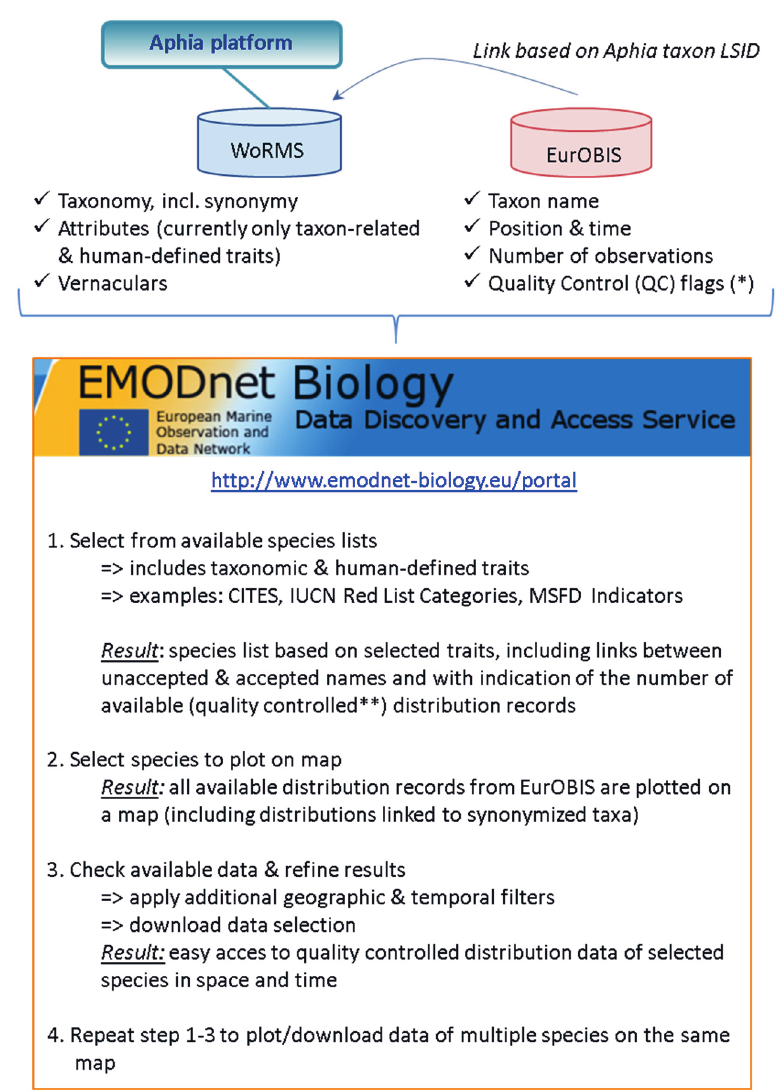
Figure 4. Schematic representation of how WoRMS and EurOBIS are brought together into the EMODnet Biology Data Portal, allowing a combination of taxonomy, traits and distribution information. EMODnet Biology can be seen as a “layer” on top of the EurOBIS database, and is pulling additional taxonomic and attribute data—based on the Aphia taxon LSID—from WoRMS, which is hosted in the Aphia platform. This unique combination allows searching for distribution data based on traits, benefiting from the strengths of both systems (e.g., quality control on the EurOBIS data and expert-validated information in WoRMS). *: the quality control procedures on EurOBIS data are described by Vandepitte et al . [89]; **: for EMODnet Biology, each data record has to comply to a minimum quality, related to taxonomy and geography before it is made available through the data portal